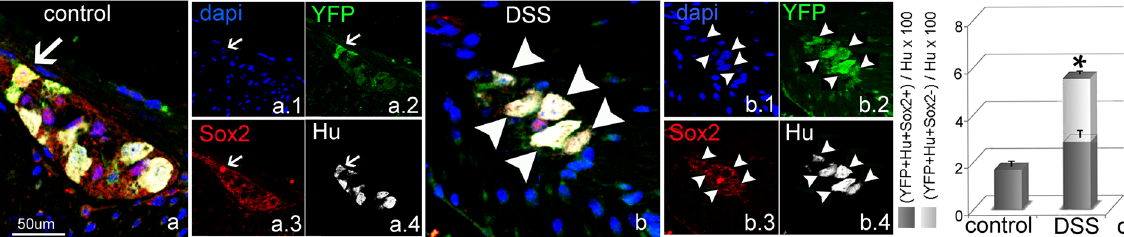
Figure 8. Colitis induces YFP + Hu + cells that subsequently downregulate Sox2 expression. In the myenteric ganglia of control mice, all YFP + Hu + cells (YFP green, Hu white) express Sox2 (red) ( a – a.4 arrow). Following DSS 50% of the YFP + neurons no longer express Sox2 protein ( b – b . 4 arrowheads). A 25% increase in Hu + YFP + Sox2 + cells is still observed in DSS-treated mice, ( c , blue bar), but many of the new Hu + neurons are negative for Sox2 protein expression ( c , green bar). * p < 0.05. (All Images were taken at